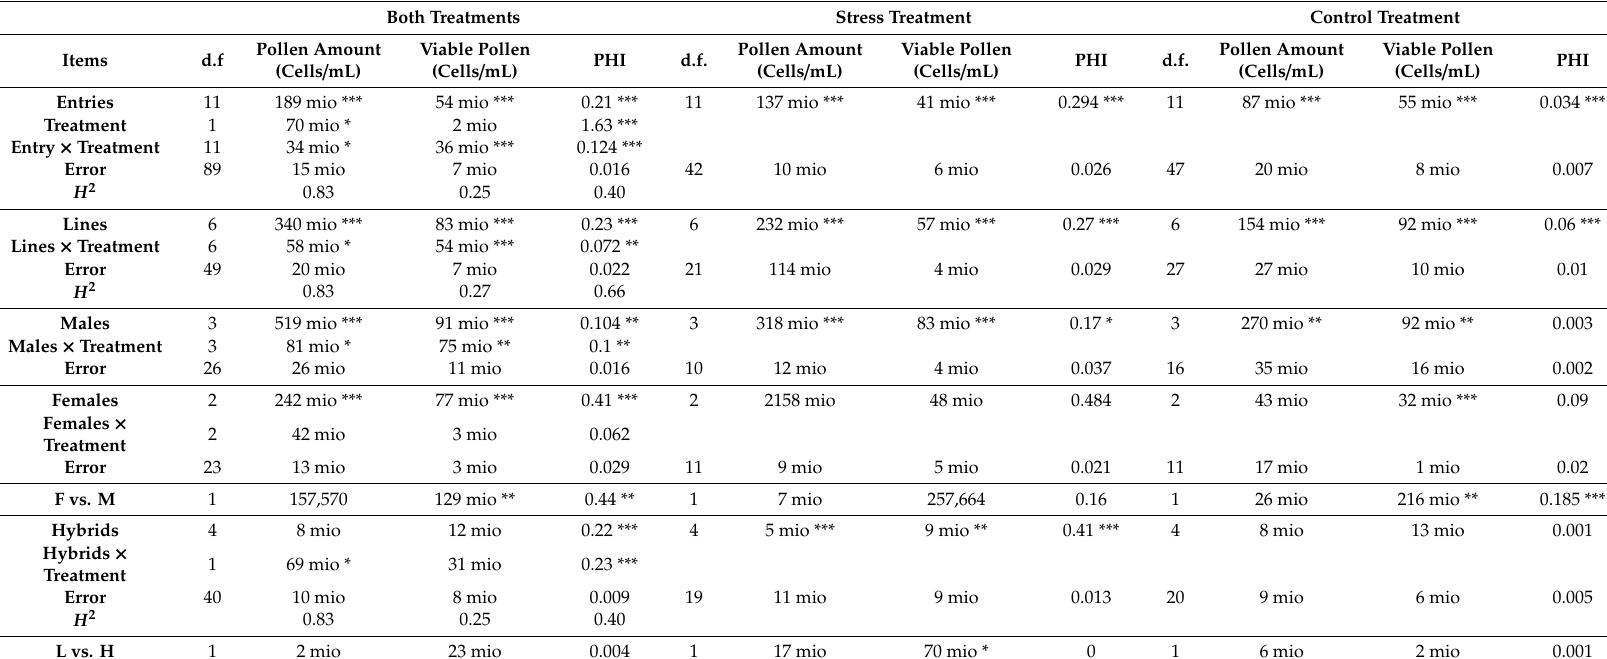
Table 4. Genotypic variances (mean squares) and their treatment interaction for the traits pollen amount (cells / mL), viable pollen number (cells / mL) and panicle harvest index (PHI) for the climate chamber